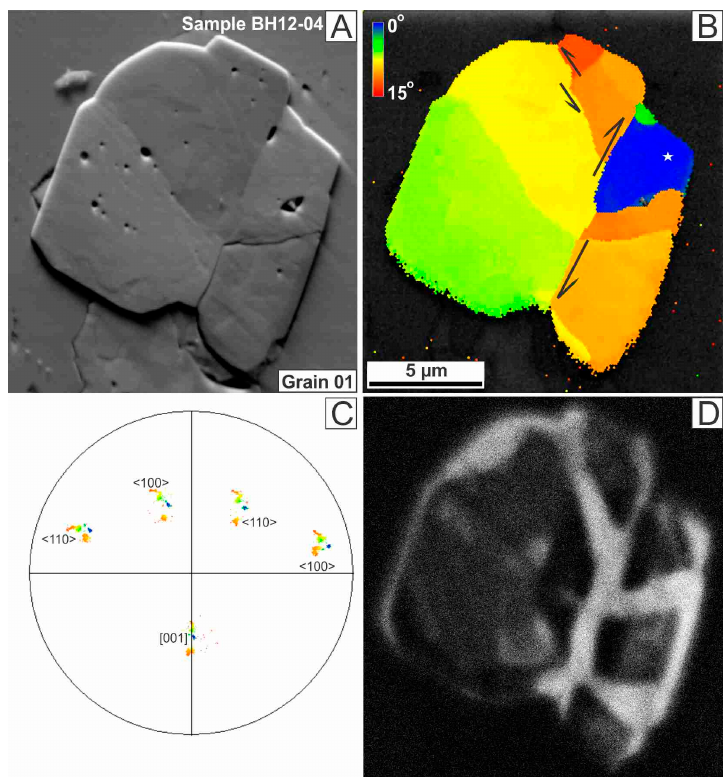
Figure 8. Data on the grain 01, sample BH12-04. ( A ) Orientation contrast image. ( B ) Cumulative misorientation EBSD map, showing the orientation of every data point with respect to a user-selected reference point (white star). Misorientation varies from 0 (blue) to 15° (red). Arrows show the apparent relative movement of subgrains along low-angle boundaries. ( C ) Lower hemisphere equal